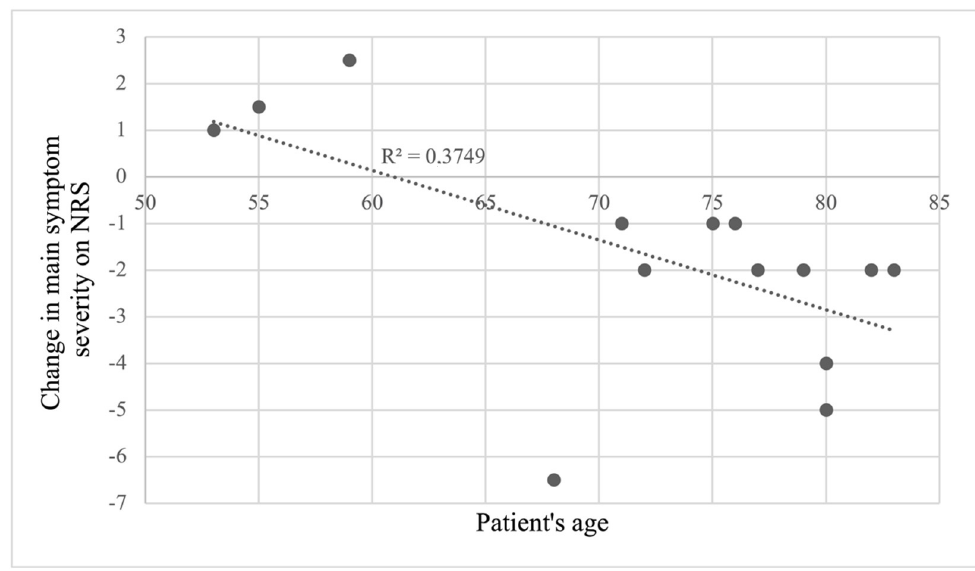
Figure 4. A correlation between the change in main symptom severity and patients’ age. The decrease in the main symptom severity was greater for older patients, whereas the younger patients did not seem to benefit from the treatment to the same degree and some even reported a worsening of symptom severity.